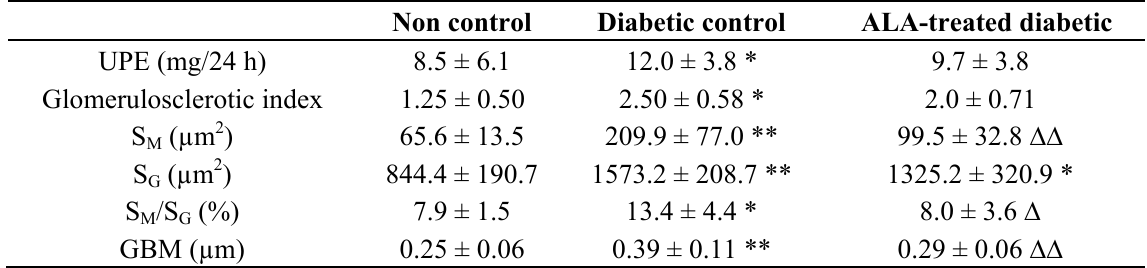
Table 2. Effects of α -lipoic acid on renal function and